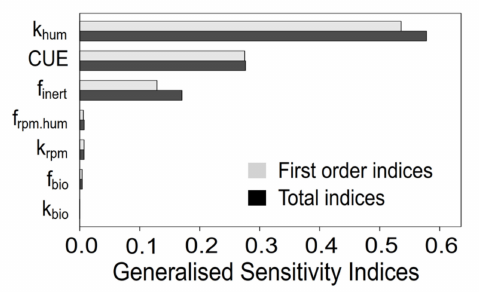
Figure 2. Generalized sensitivity of soil C dynamic to model parameters in the RothC model. The climate and soil data from a long-term field experiment under continuous wheat cropping at Broadbalk, UK were used to perform the sensitivity analysis. CUE, microbial C use efficiency; k hum , decomposition rate of humified organic carbon; f inert , the fraction of inert organic C and physio- chemically protected soil organic carbon; f rpm.hum , the proportion of initial resistant plant material (RPM) to humified organic matter (HUM); f bio , the initial fraction of microbial biomass (BIO) to total soil organic carbon; k bio , the decomposition rate of microbial biomass